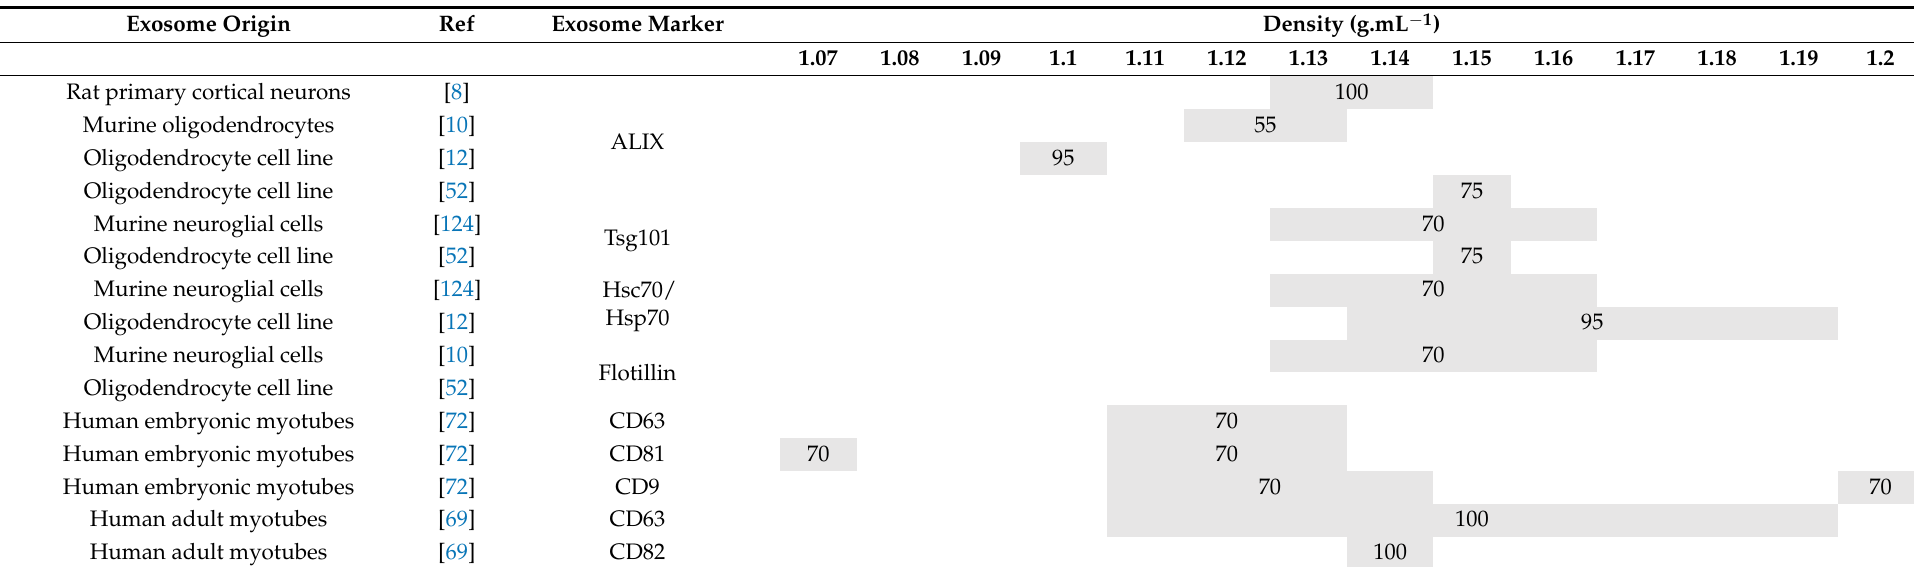
Table 2. Vesicle heterogeneity in size and variability in buoyant densities in isolated sEV